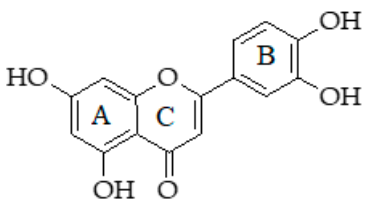
Figure 9. The chemical structure of luteolin.